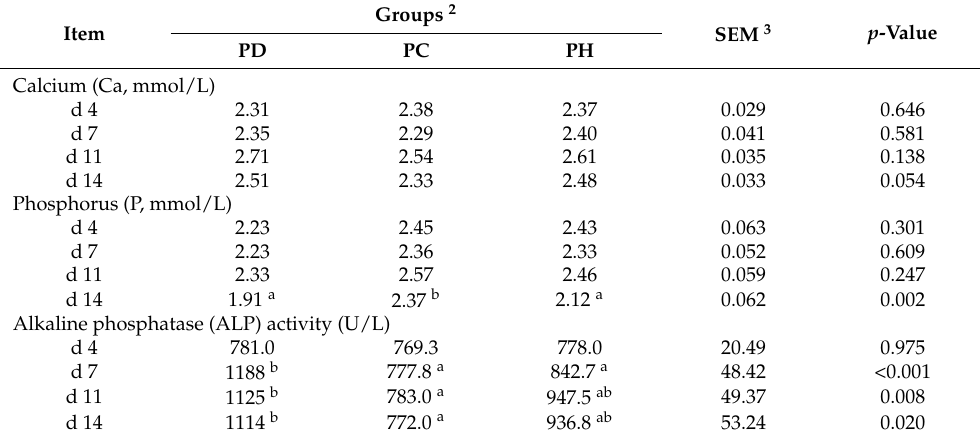
Table 4. Effects of dietary phosphorus (P) deficiency and high P content on serum variables of goslings.